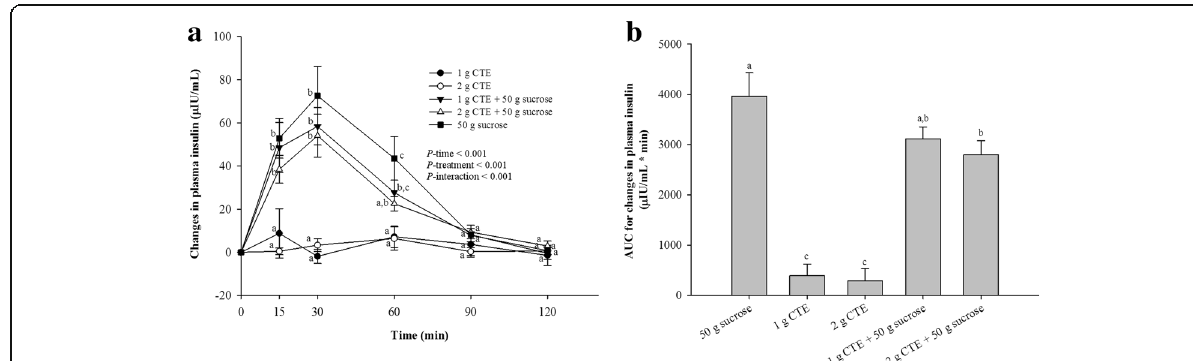
Fig. 3 Postprandial plasma insulin response of five different beverages. a Changes in insulin concentrations during 120 min of five different beverages; ( b ) Insulin changes area under the curves (AUCs) of five different beverages. Values are means ± SEM, n = 15. Different letters are significantly different ( P < 0.05)